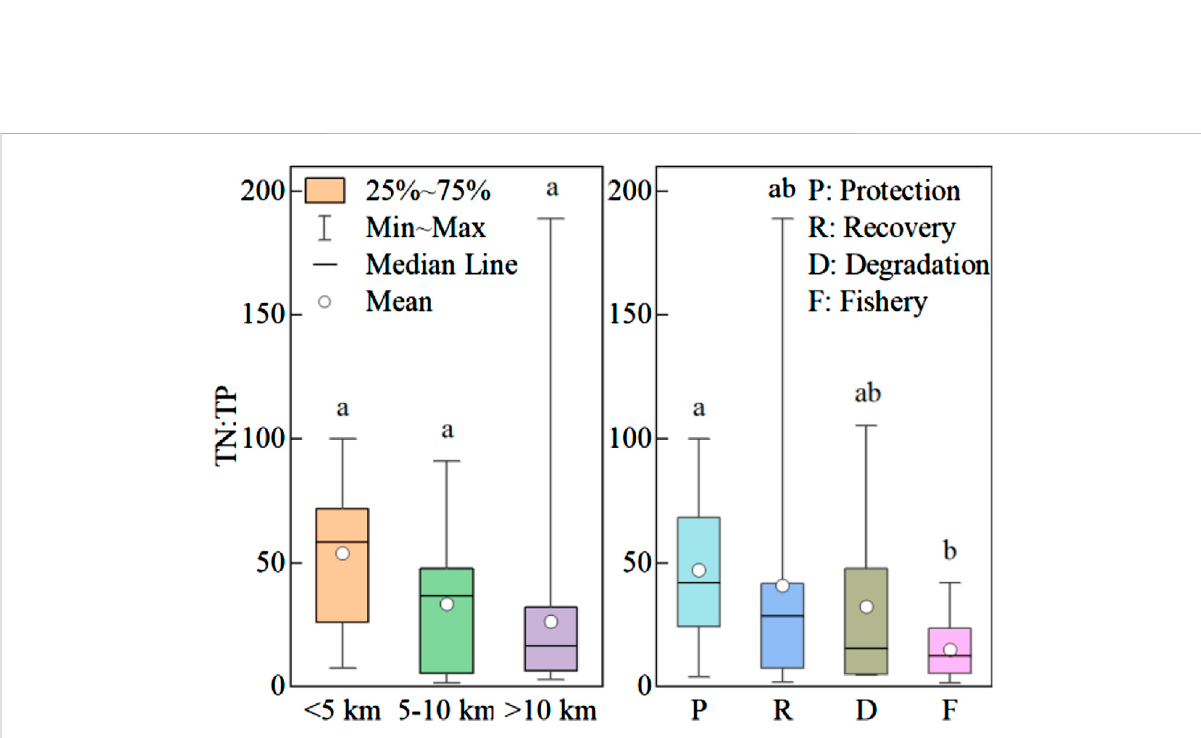
FIGURE 7 TN:TP ratios (mol/mol) in small water bodies under different distance bands and management types.